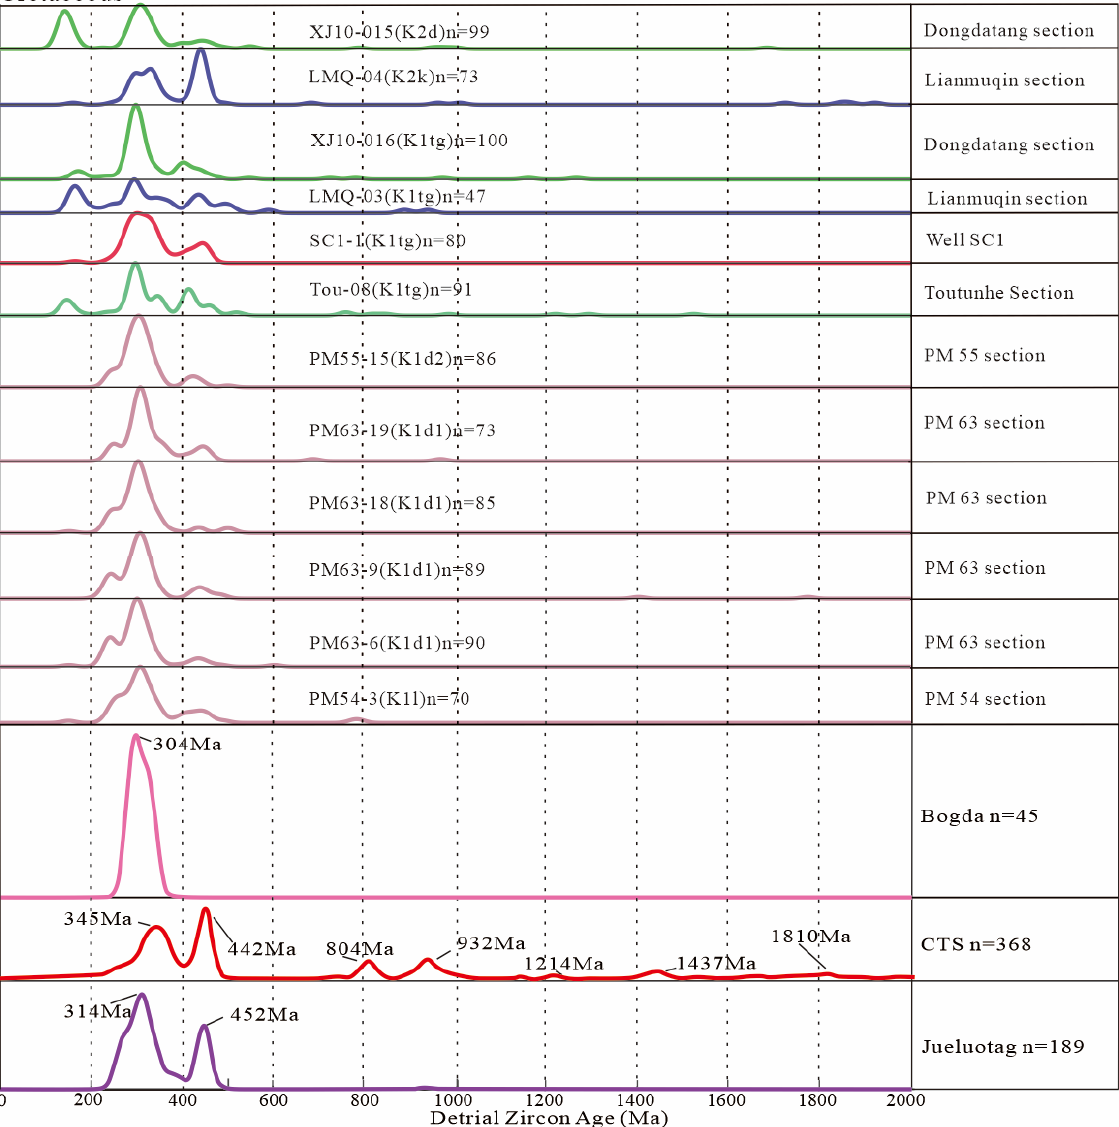
Figure 12. Relative probability map of U-Pb ages of Cretaceous detrital zircons (data from [24,43,63] and this study); for map locations, see Figures 1c and 3. Age spectra of potential-source-area features (data from [64,65,68,74] and references therein).